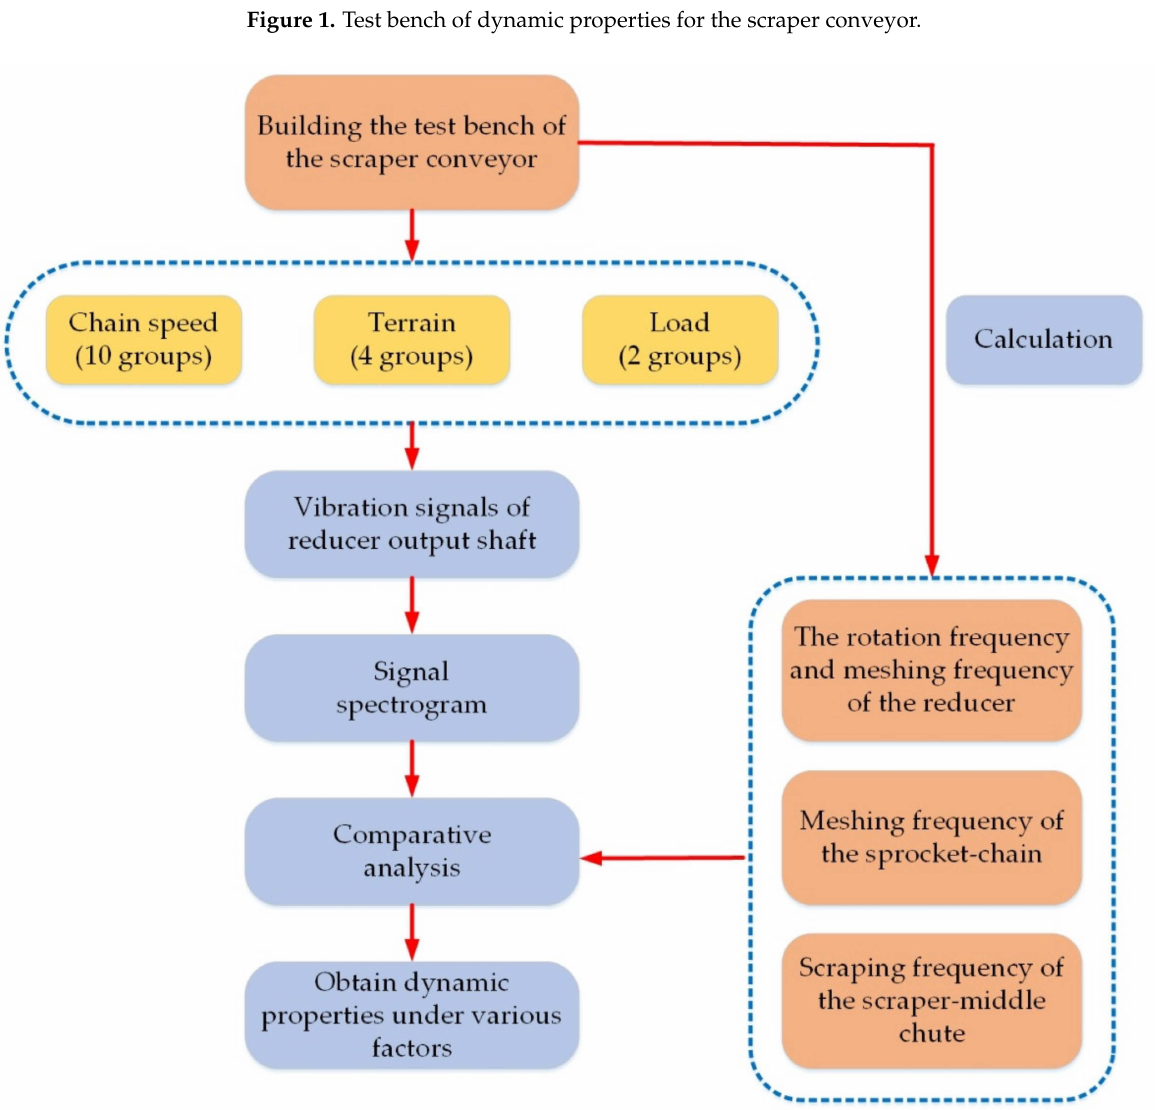
Figure 2. The research idea of this